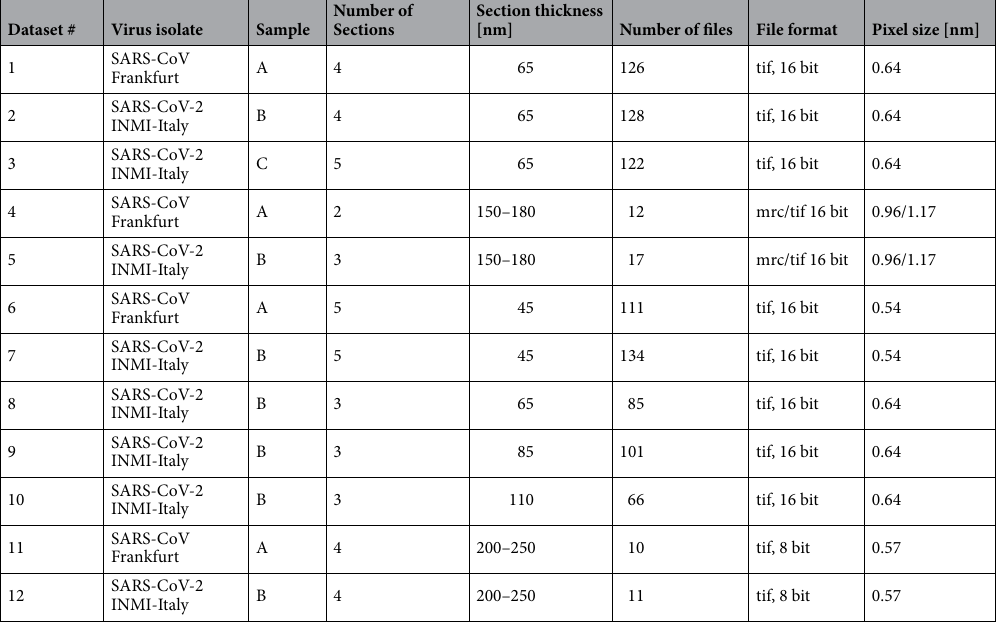
Table 1. Overview of the datasets used for virus particle